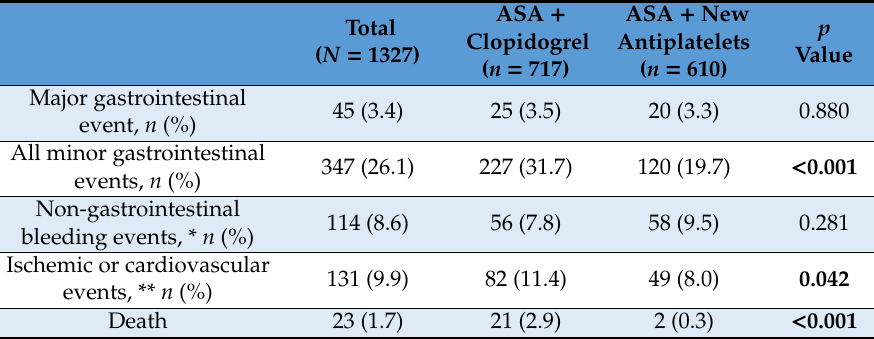
Table 4. Events during follow-up by treatment group.